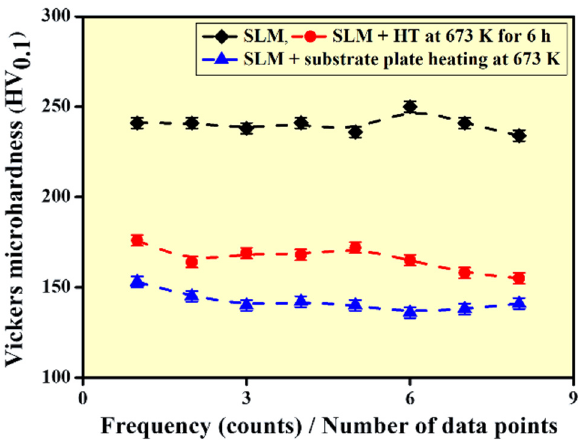
Figure 6. Vickers microhardness data of the Al-20Si-5Fe-3Cu-1Mg alloy observed under different conditions namely: as-prepared SLM, SLM + thermal treatment at 673 K for 6 h and finally SLM fabrication with a substrate plate heating of 673 K.